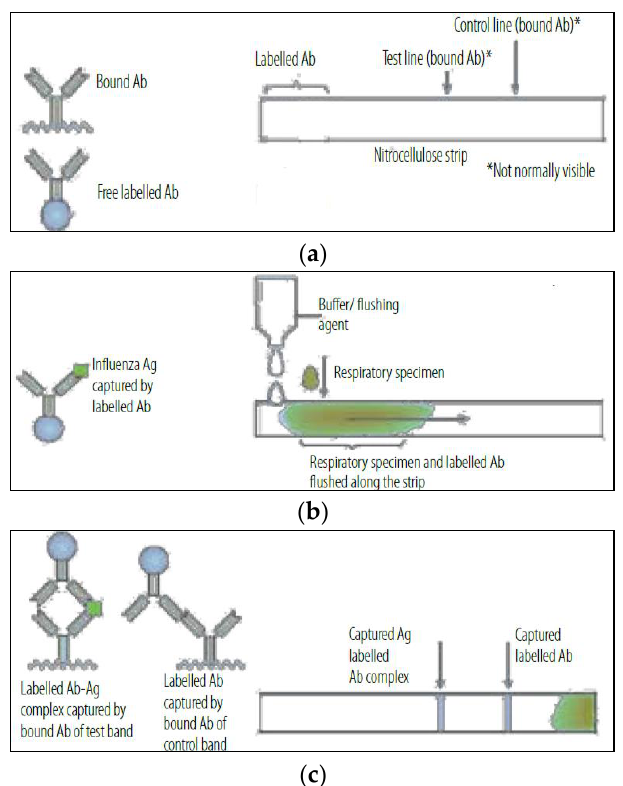
Figure 1. RIDT mode of action: ( a ) Bounding dye-labeled antibodies specific for target antigen onto the nitrocellulose strip; ( b ) Addition of respiratory specimen with buffer to the strip; ( c ) Trapping antibodies on the test line if target antigen is presented. Reproduced with permission from WHO on behalf of the Special Programme for Research and Training in Tropical Diseases, Use of Influenza Rapid Diagnostic Tests; published by WHO Library Cataloguing-in-Publication Data, 2010.